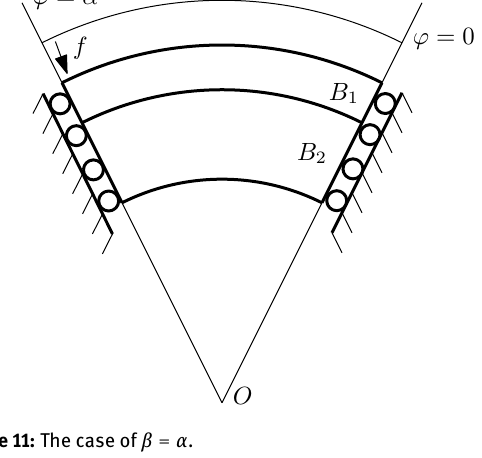
Figure 7: The graph of ϕ 2 = ϕ 2 ( φ ) .